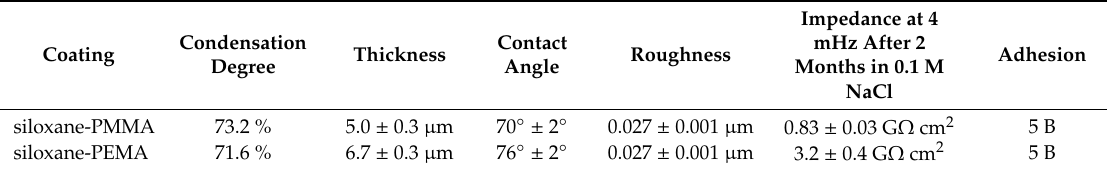
Table 6. Representative parameters of two siloxane coatings.